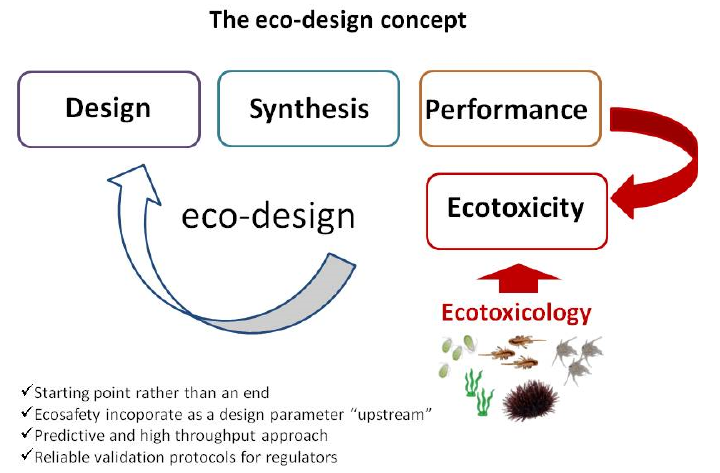
Figure 1. Schematic description of role of ecotoxicology in defining eco-design along ENM synthesis and development.